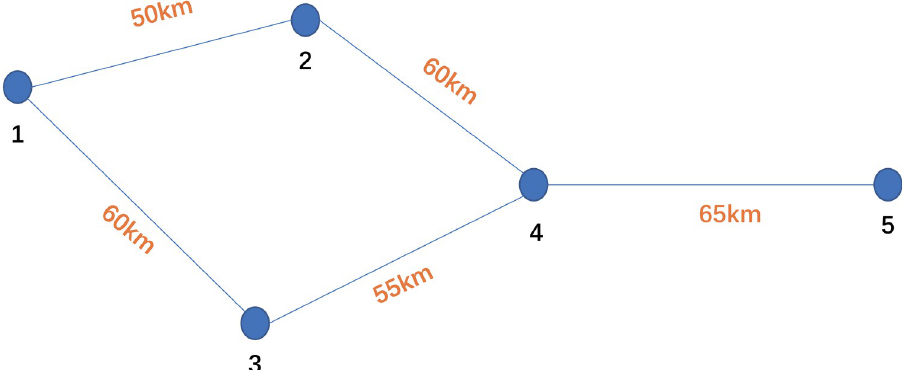
Fig 3. The illustrative railway